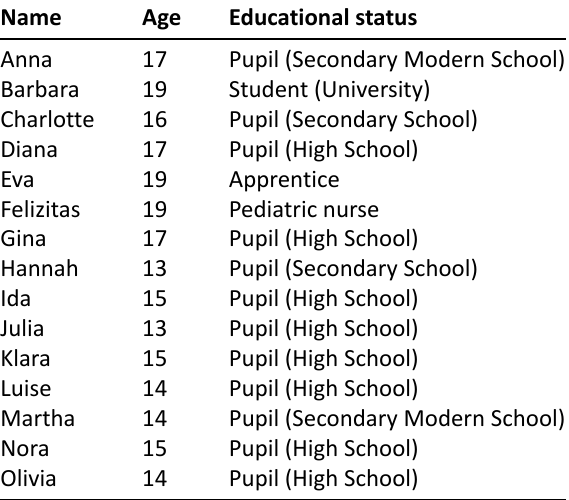
Table 1. Sample characteristics.